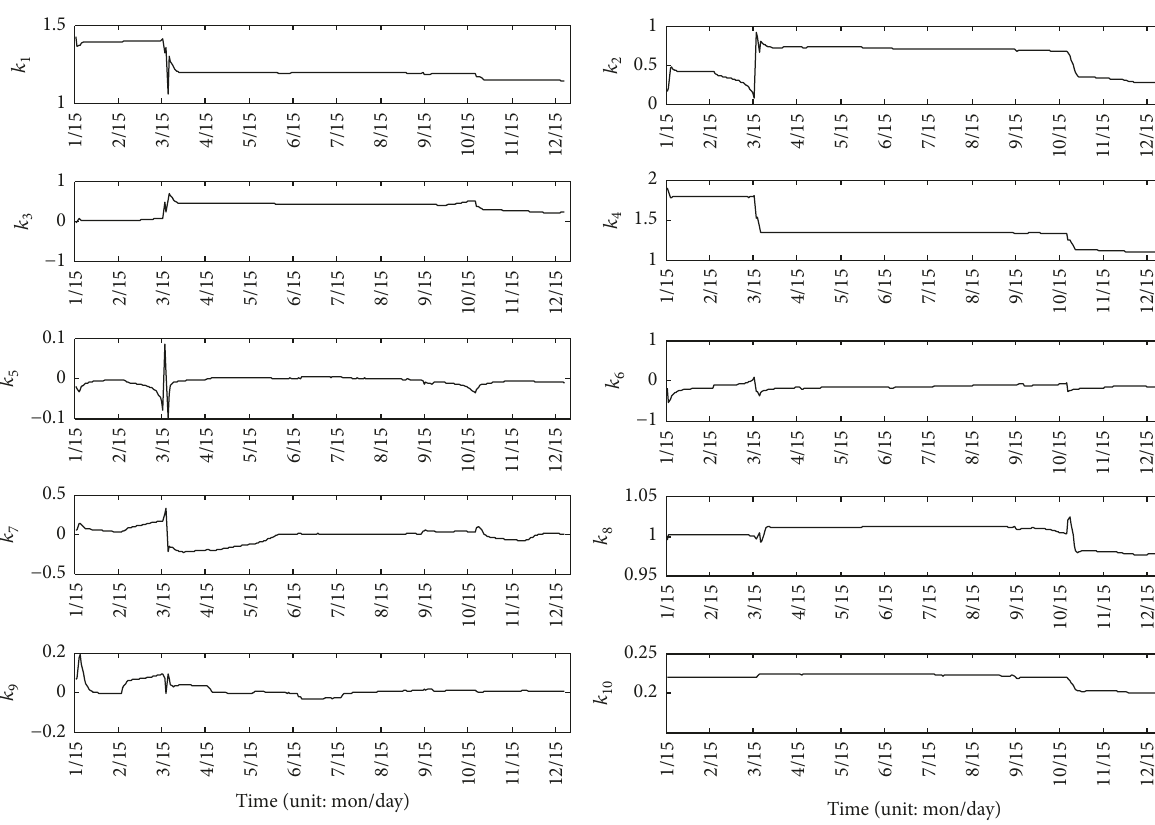
Figure 1: Real-time estimated values of ten unknown model